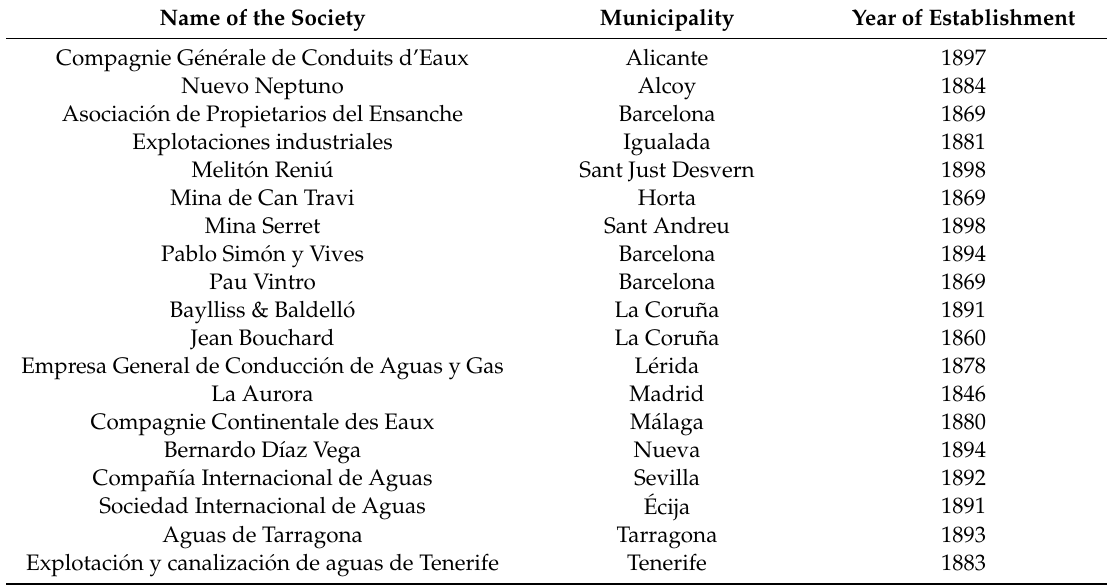
Table 6. Companies established in the 19th century that did not operate for more than 5